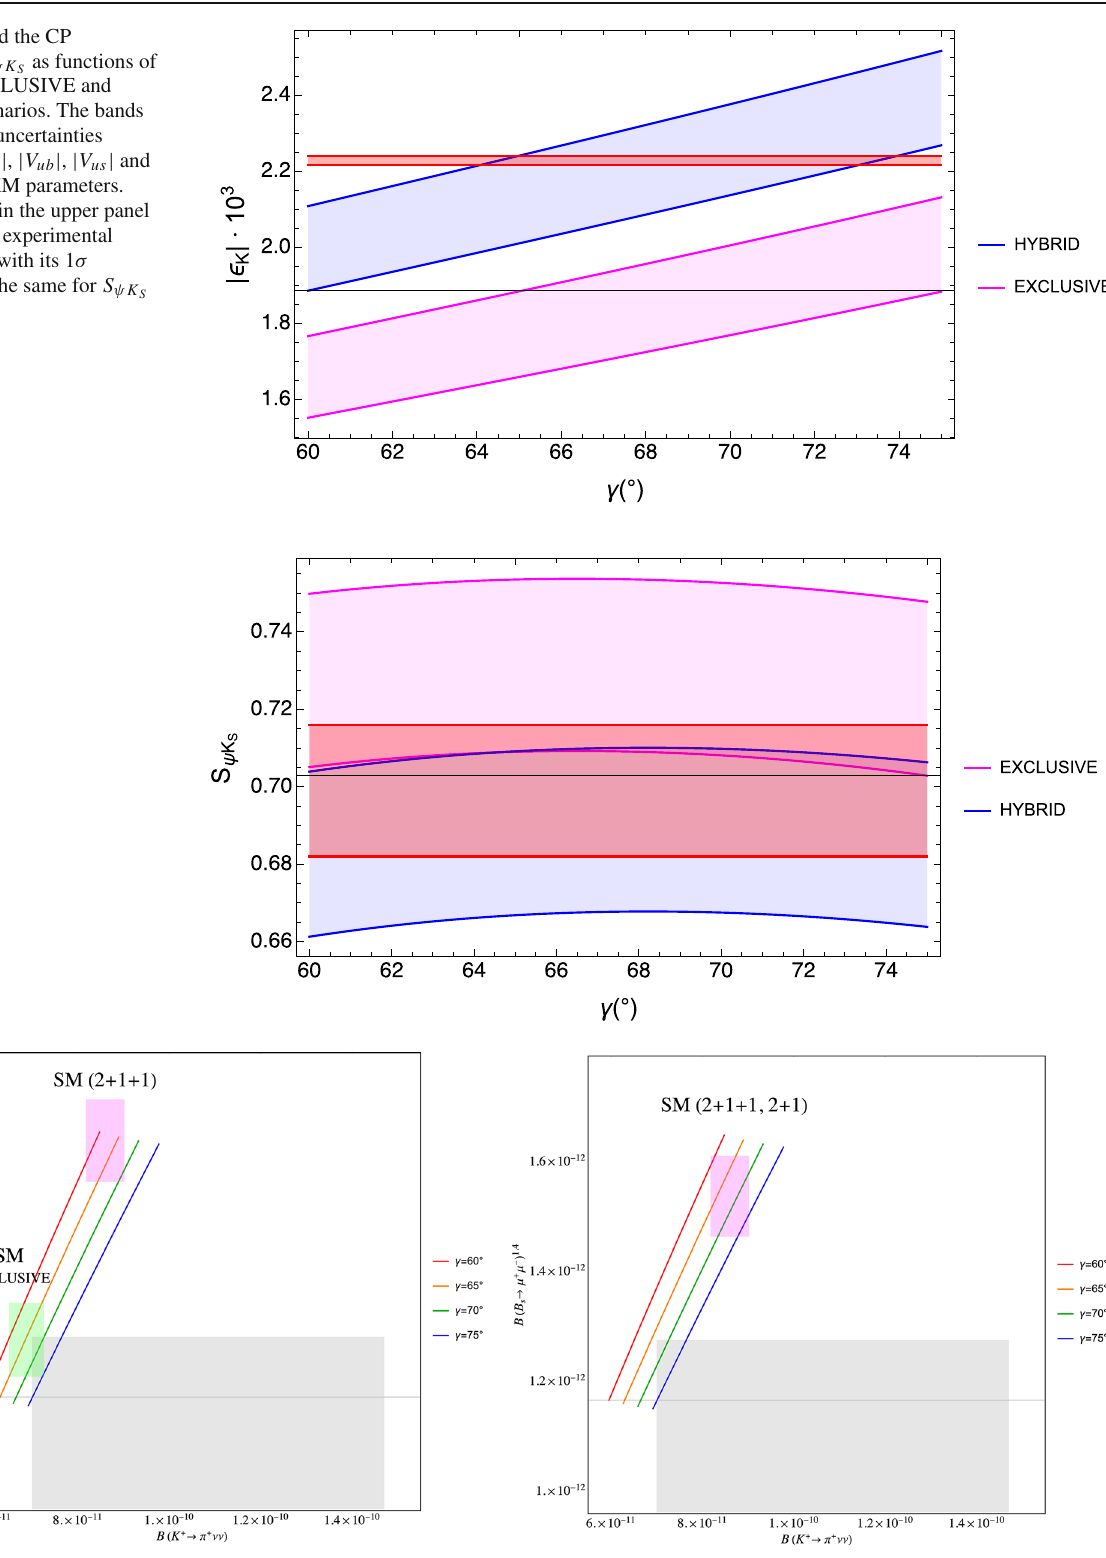
Fig. 7 Thecorrelationof B ( K + → π + ν ¯ ν) with B ( B s → μ + μ − ) 1 . 4 of [7] for different values of γ within the SM. The SM area corresponds to the HPQCD 2 + 1 + 1 input (left panel) and to the 2 + 1 + 1 and